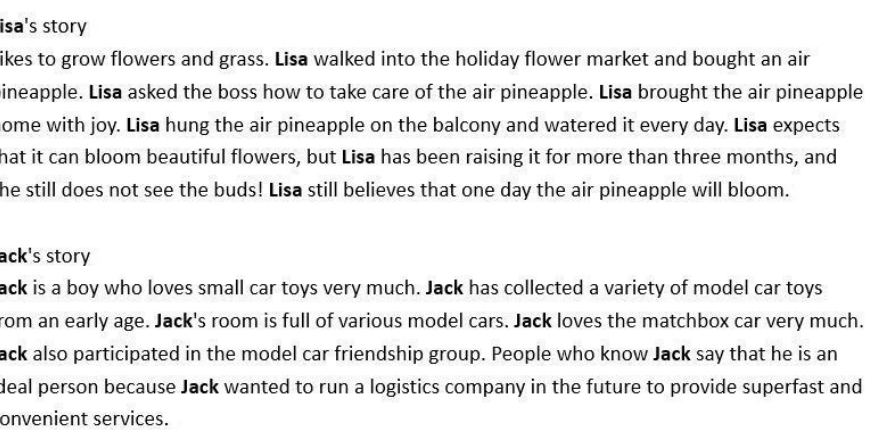
Figure 3. Two of the twelve audio stories (original text written in Chinese). Each story file includes a keyword (words rendered in boldface) that appears seven times in the story.